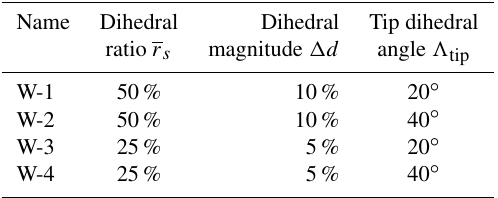
Table 1. The parameters of the planforms of the four upwind dihe- dral blades used for the